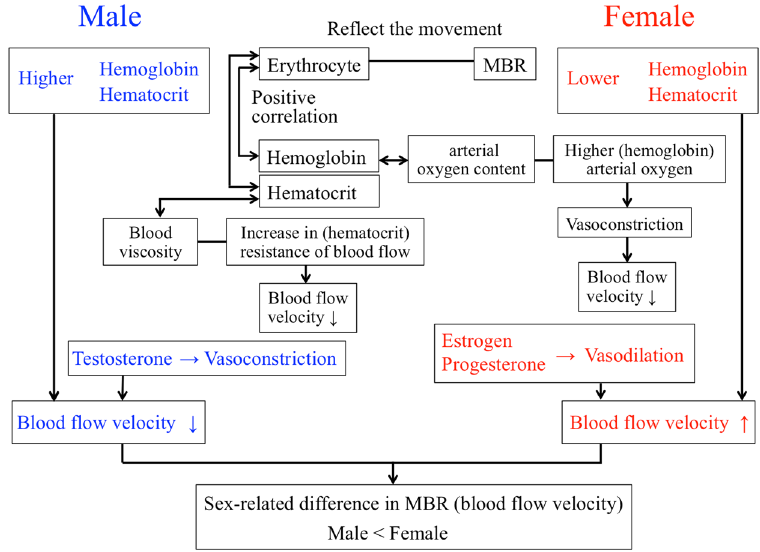
Figure 4. A schematic diagram to present the hypothesis.